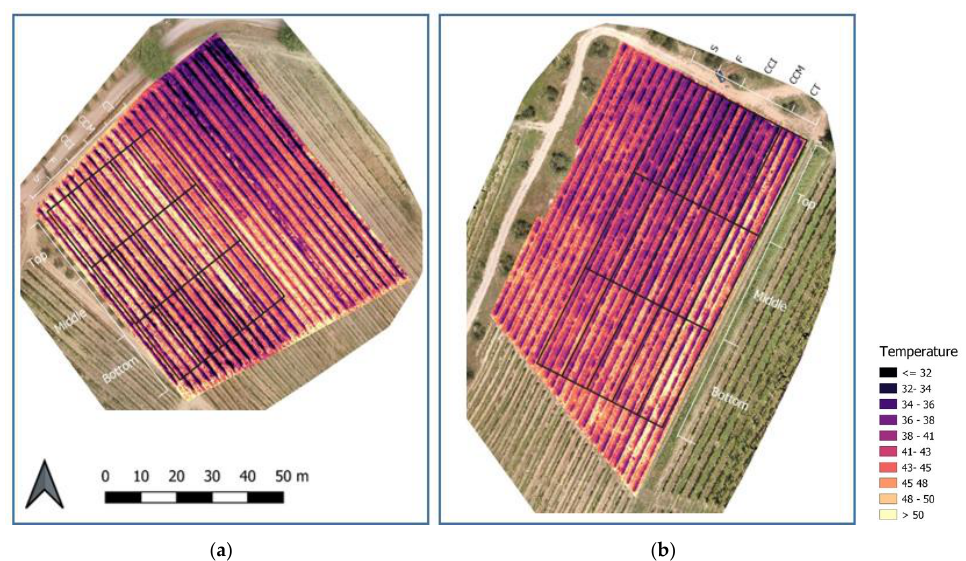
Figure 9. Surface temperature image referred to the entire experimental plots in ( a ) MV and ( b ) SG.